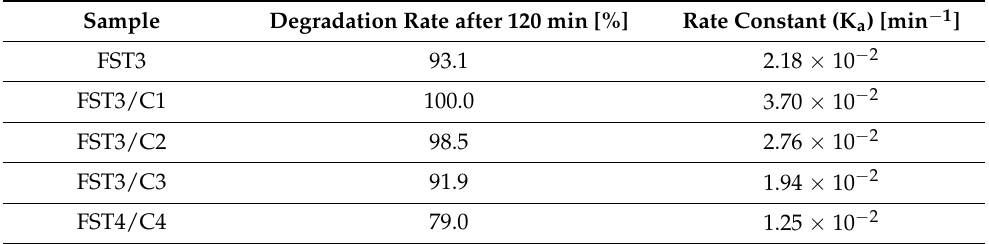
Figure 4. ( a ) Brilliant Black BN degradation rates for different MWCNT loadings on F, Sm 3+ co-doped TiO 2 (0.6% Sm 3+ ) line plots with error bars; and ( b ) pseudo-first-order rate constants for degradation of Brilliant Black BN using photocatalysts with different MWCNT loadings on F, Sm 3+ co-doped TiO 2 prediction lines with 95% confidence intervals. Table 4. Degradation rates and rate constants for different MWCNT loadings on F, Sm 3+ co-doped TiO 2 after 2 h of solar